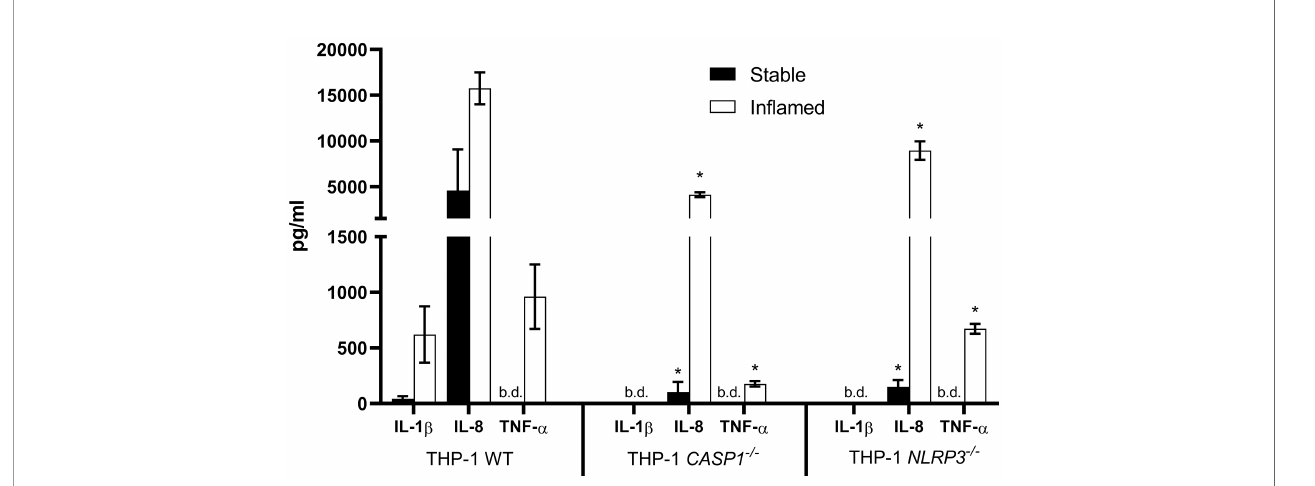
FIGURE 4 | Cytokine release into the basolateral compartment after 48 h of stable (full bars) and in fl amed (open bars) triple culture with WT, CASP1 -/- or NLRP3 -/- THP-1 cells, as assessed by ELISA. Mean ± SD of N = 3. *p < 0.05, compared to the respective WT triple culture. “ b.d. ” = below detection